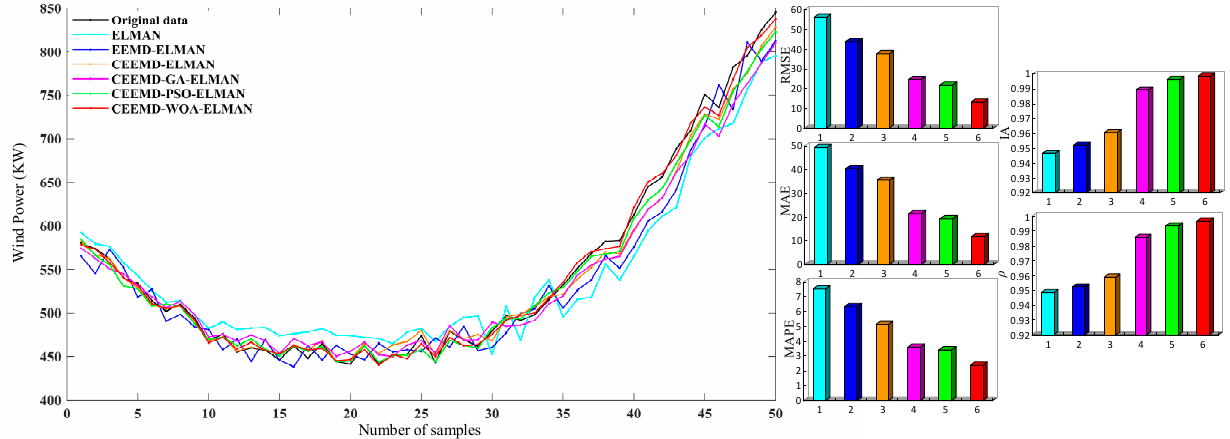
Figure 12. Wind power prediction results of six models of Number Three wind turbine.